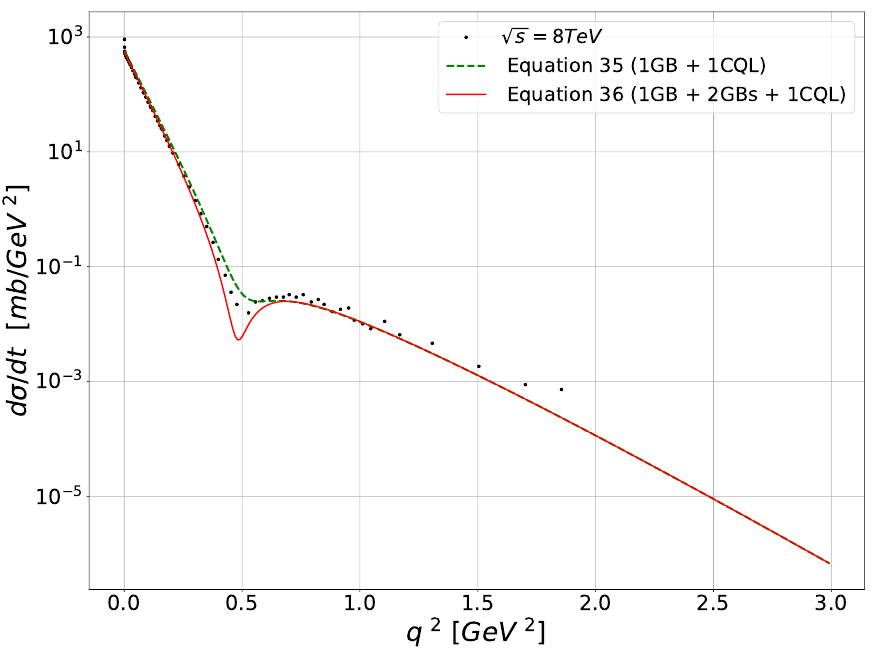
√ s = 8 TeV. Black dots are experimental